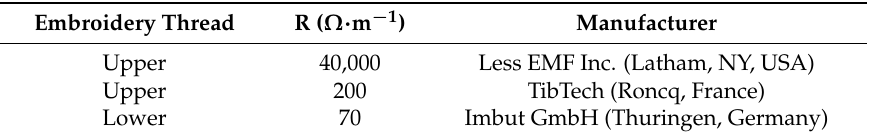
Table 2. Characteristics of thread materials used in the embroidery patterns. Embroidery Thread